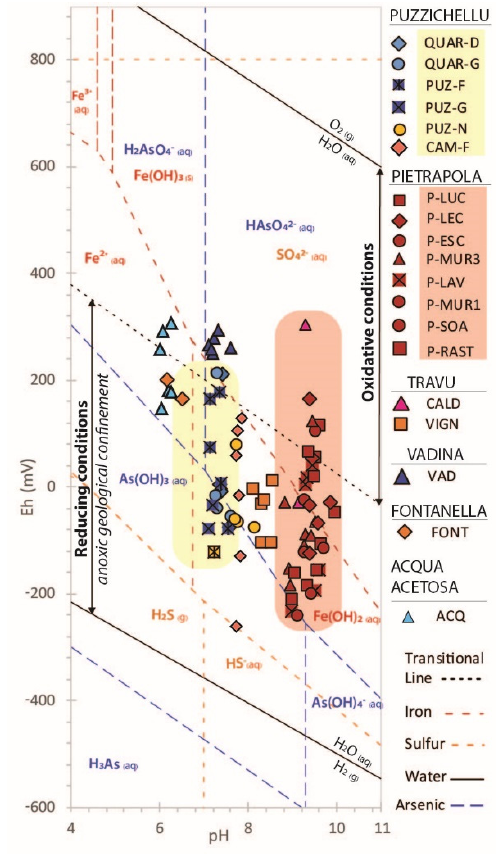
Figure 7. Pourbaix diagram of sulphur, arsenic and iron elements. The spring group of Pietrapola is displayed in red background while Puzzichellu is displayed in yellow background.